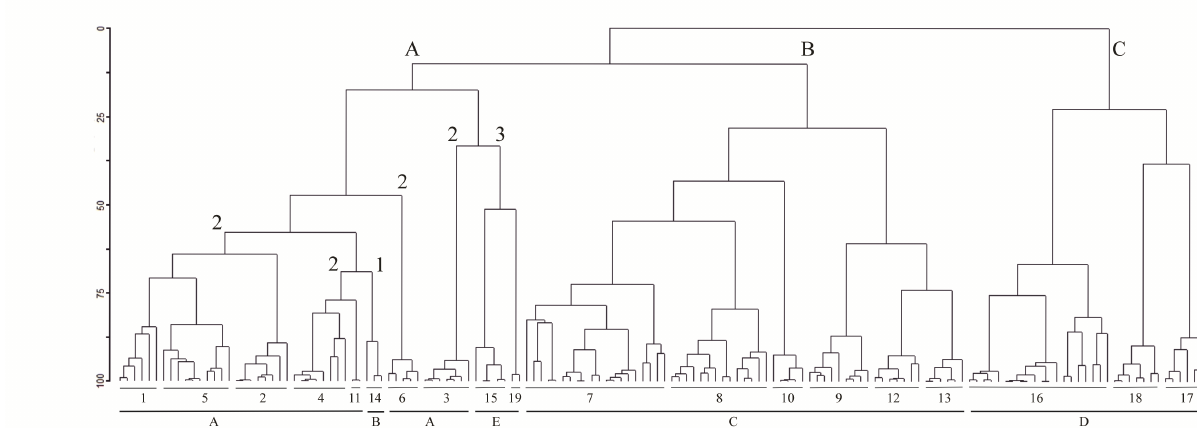
Figure 2. Dendrogram from the cluster analysis showing the associations and alliances: 1 Isolepido cernuae- Ranunculetum saniculifoliae; 2 Ranunculo ophioglossifolii-Callitrichetum brutiae; 3 Ranunculo ophioglossifolii- Elatinetum alsinastri; 4 Coronopo squamati-Damasonietum polispermi; 5 Ranunculo saniculifolii-Elatinetum macropodae; 6. Pilulario minutae-Isoetetum longissimae; 7. Solenopsio laurentiae-Isoetetum todaroanae ; 8. Poo jubatae-Isoetetum histricis; 9. Solenopsidetum caespitosae; 10. Radiolo linoidis-Solenopsidetum parvulae; 11. Triglochido laxiflorae-Isoetetum longissimae; 12. Anagallido parviflorae-Spergularietum arvensis; 13. Anagallido parviflorae-Molinerielletum minutae ; 14. Myosuro minimi-Buillardietum vaillantii; 15. Damasonio alismae-Verbenetum supinae; 16. Phalarido minoris-Agrostidetum pourretii; 17. Moenchio erectae-Isoetetum siculae; 18. Chamaemelo mixti-Agrostidetum pourretii; 19. Heliotropo supini-Heleochloetum schoenoidis; A. Preslion cervinae ; B. Isoetion ; C. Cicendio filiformis - Solenopsion laurentiae ; D. Agrostion salmaticae ; E. Verbenion